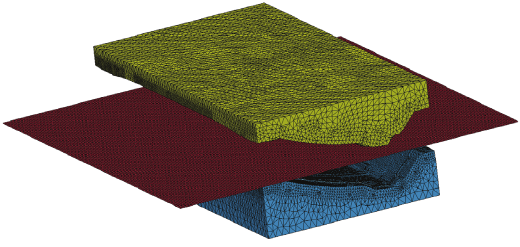
Figure 4: Grid division diagram. Table 5: Heat transfer